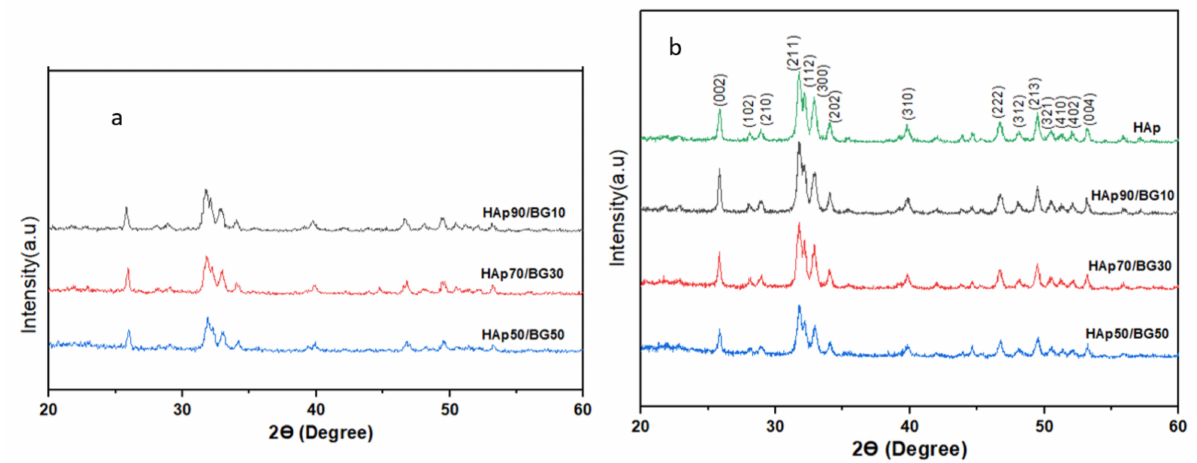
Figure 3. XRD patterns for HAp and HAp/BG cement samples: ( a ) before sintering, and ( b ) after sintering at 700 ◦